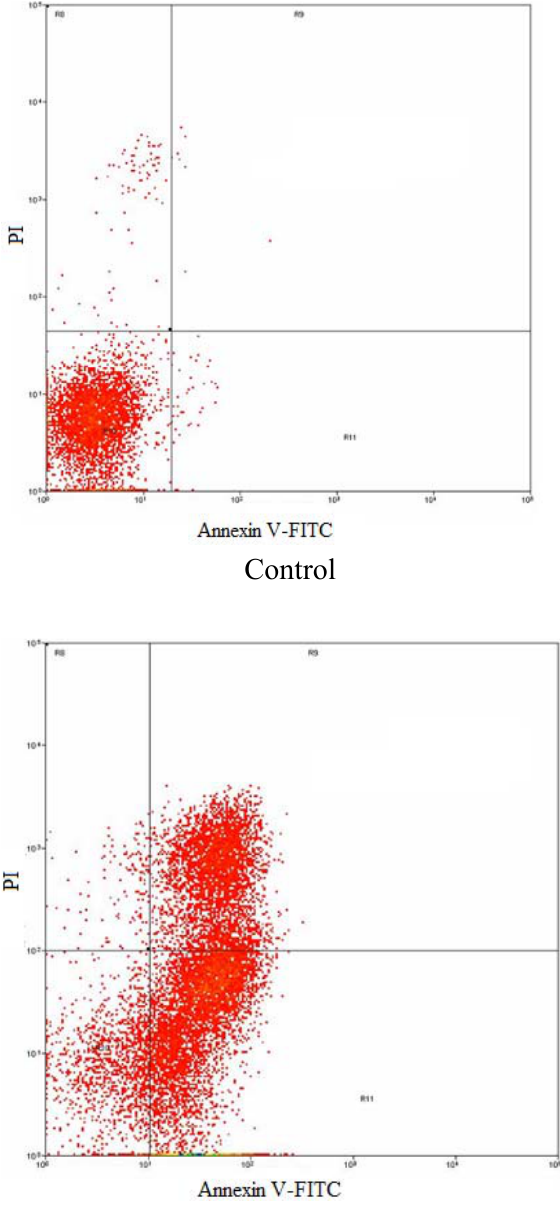
Figure 5. Flow cytometric analysis of phosphatidylserine externalization (annexin V binding) and cell membrane integrity (PI staining) in Hep G2 cells undergoing